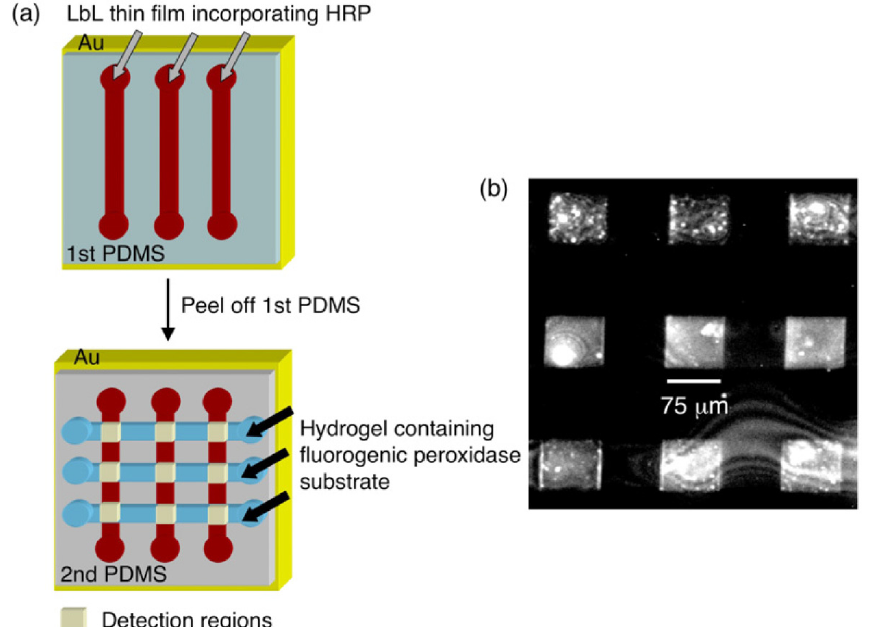
Figure 7. ( a ) Illustration of the steps to form the PEM/HRP nanostructures, and the fluorogenic-peroxidase-containing hydrogel generated perpendicular to it; ( b ) Micrographs showing fluorescence at the intersection of the structures (PEM/HRP and hydrogel) due to the enzymatic reaction. Reprinted with permission from [50] © IOP